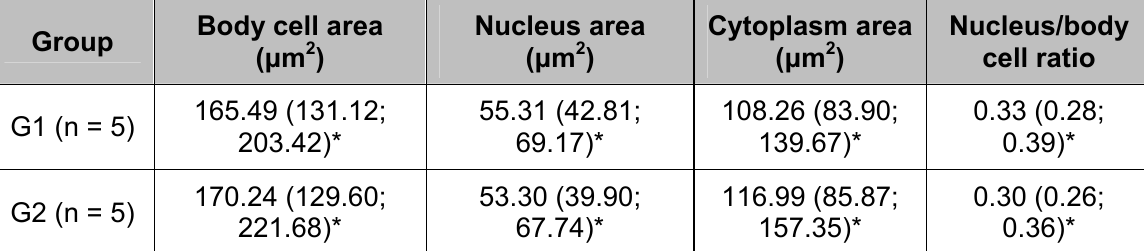
Table 2. Median and percentiles (P25; P75) of areas of the body cell, nucleus and cytoplasm, and the nucleus/body cell ratio of NADH-diaphorase-positive neurons from jejunum of healthy rats (G1) and those submitted to infection with a genotype III Toxoplasma gondii (G2) strain for 24 hours